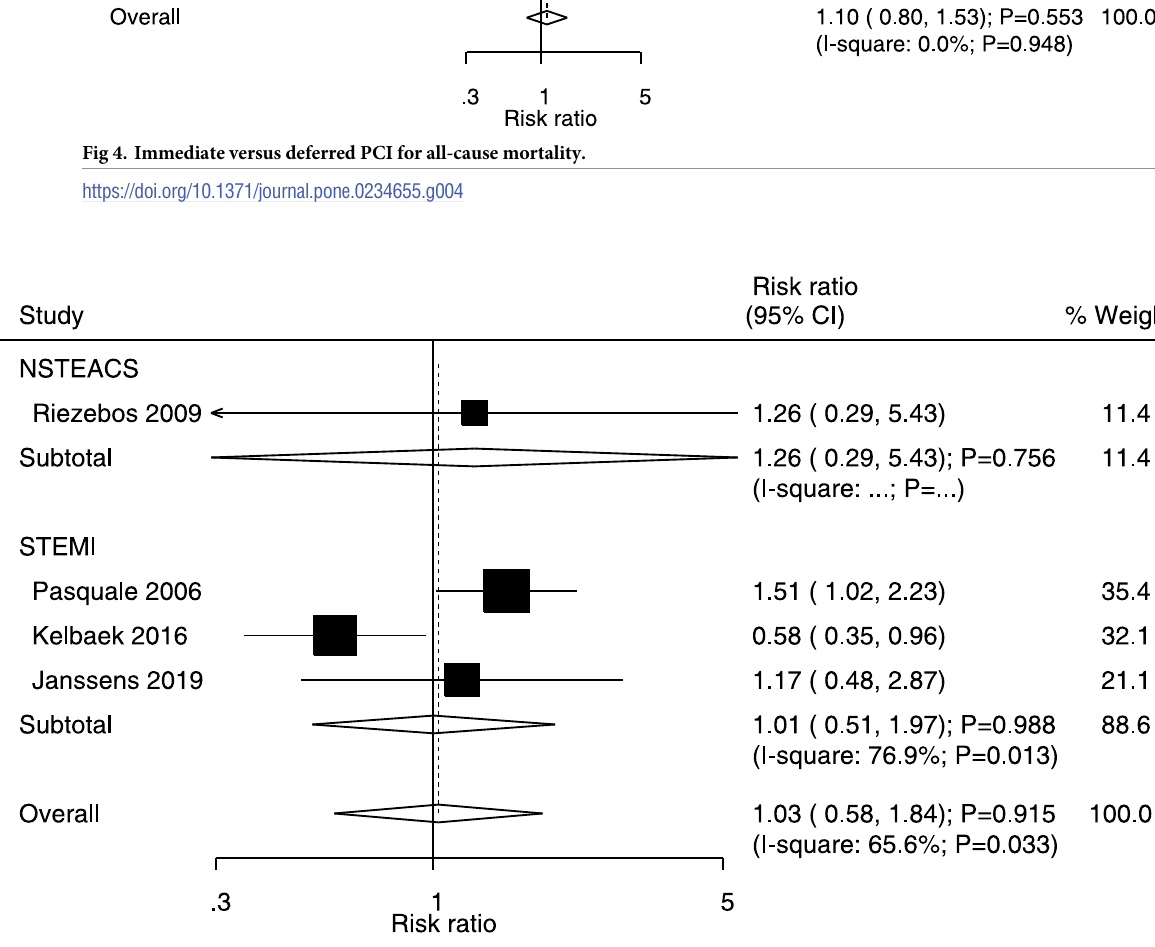
Fig 5. Immediate versus deferred PCI for TVR.